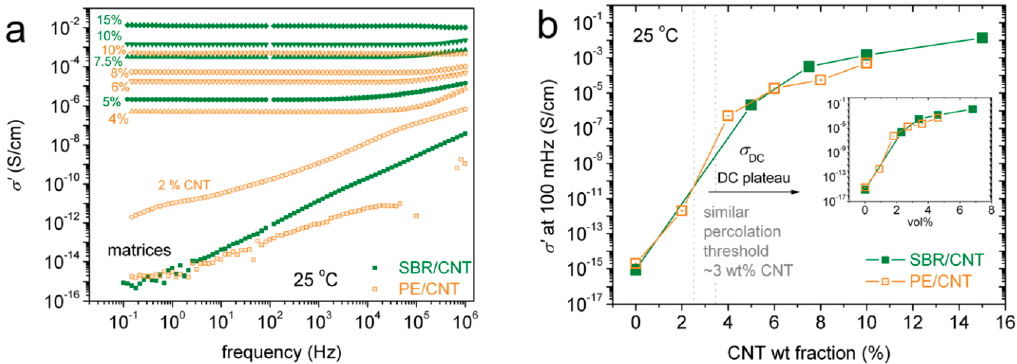
Figure 15. Real conductivity versus ( a ) frequency and ( b ) CNT wt fraction for PE/MWCNT and SBR/MWCNT composites [68].